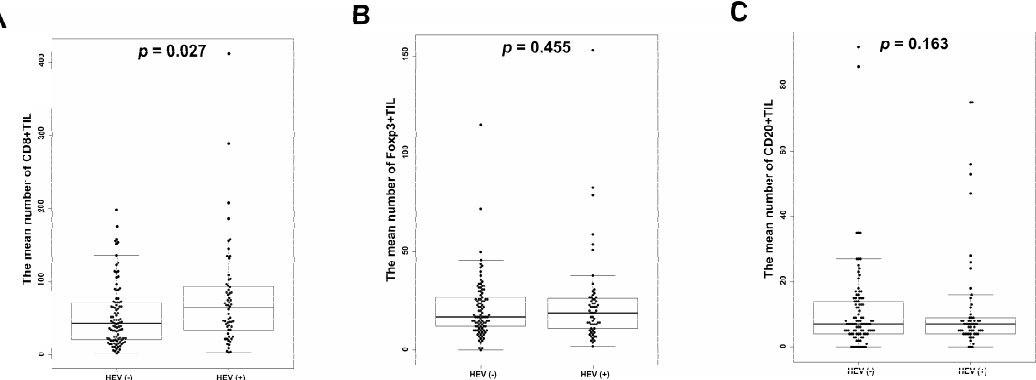
Figure 2. Di ff erences in the mean number of TILs according to the presence or absence of HEVs in gastric cancer. ( A ) A significant elevation of the mean number of CD8 + TILs in HEV-positive patients compared to HEV-negative patients ( p = 0.027); Non-significant increases of the mean number of Foxp3 + TILs ( B ) ( p = 0.455) and CD20 + TILs ( C ) ( p = 0.163) in HEV-positive cases as compared to HEV-negative cases.